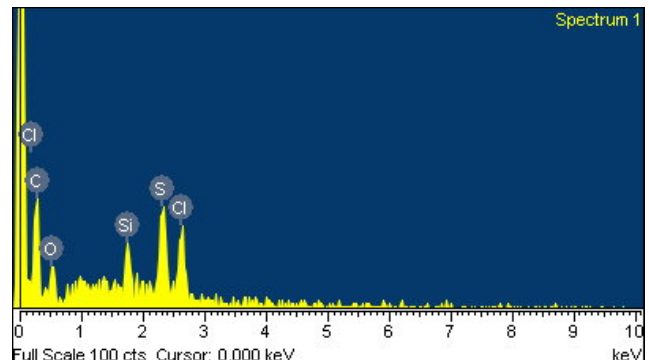
Figure 2. Elements of the polyaniline/PVA film measured by energy dispersive